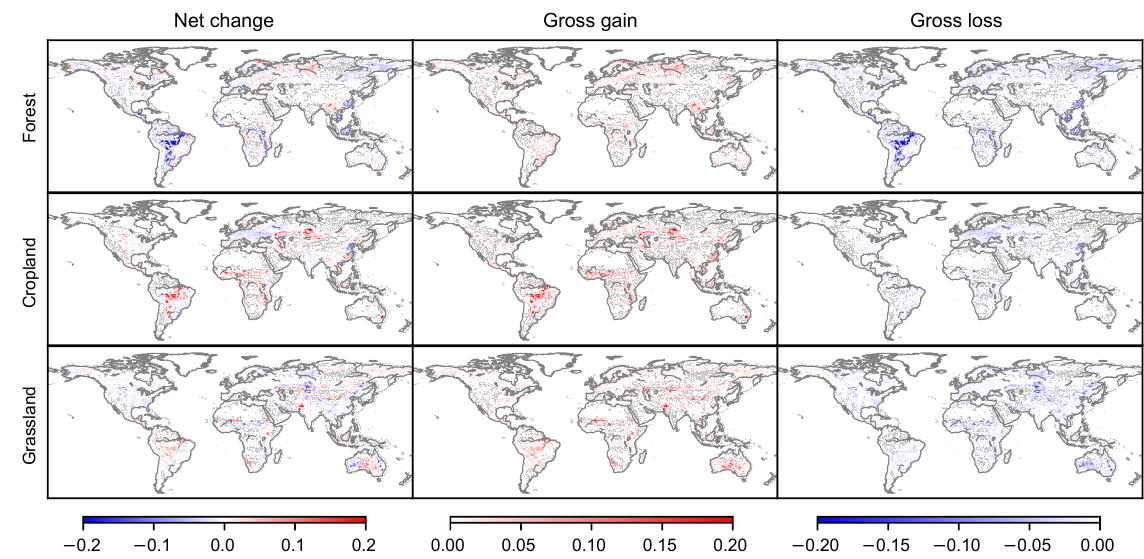
Figure 3. Spatial distributions of net and cumulative gross changes in forest, cropland and grassland PFTs between 1992 and 2015 derived from the ESA CCI data. The color scales indicate the changed fraction in each half-degree grid